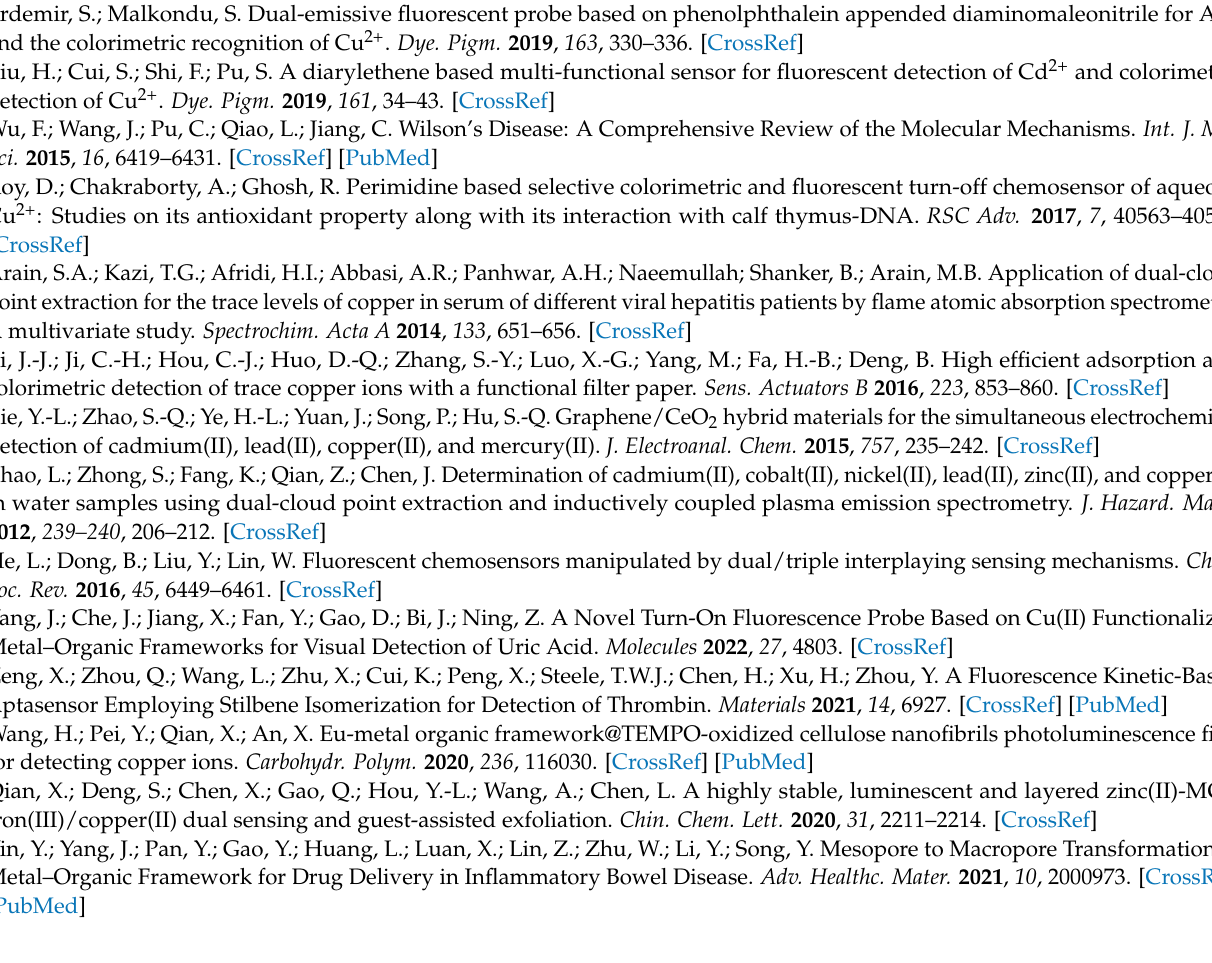
Emission of synthetic materials in different proportions. Figure S4. (a) Excitation spectra of CDs-F2 monitored at 615 nm and 410 nm, respectively. (b) Emission of CDs-F2 with excitation wavelengths from 260 to 310 nm. Figure S5. SEM image of CDs-F2. Figure S6. FT-IR spectra analysis of F1, CDs-F2, and CDs. Figure S7. Eu 3d XPS spectra of Eu(NO 3 ) 3 · H 2 O and CDs-F2. Figure S8. EDX spectra of CDs-F2. Figure S9. The response of CDs-F2 toward coexisting metal ions in the presence and absence of Cu 2+ : (a) λ em = 410 nm; (b) λ em = 615 nm. Figure S10. Fluorescence lifetimes of CDs-F2 in the absence (a,c) and presence (b,d) of Cu 2+ in aqueous solution. Table S1. CDs-F2 determined by energy-dispersive analysis by X-rays